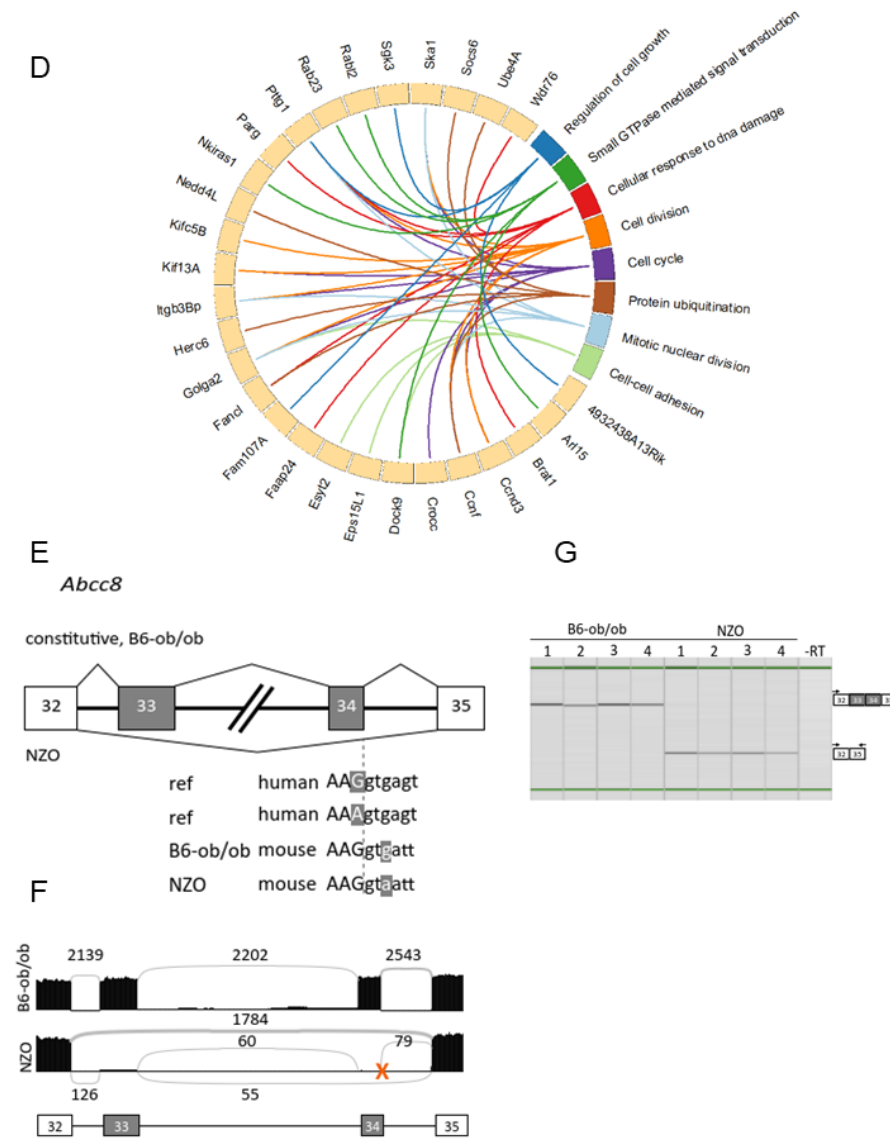
Figure 5. Impact of SNPs on alternative splicing. ( A ) Enrichment of RBP motifs in or close to differentially spliced exons and the predicted consequence for exon inclusion. ( B ) Enrichment of SNPs affecting cassette exon (CE) splicing. Bar graph summarizing the global SNPs frequency vs. SNPs located in close proximity to CE *** p ≤ 0.001, chi 2 test. ( C ) Schematic illustration of a SNP in a SRSF1 binding site downstream of an alternative exon in Akr1c12 . This polymorphism leads to enhanced skipping in islets from NZO mice. Sashimi plot and quantification are shown below. The numbers above the lines indicate the raw sequencing reads. Orange “X” marks the approximate position of RBP motif-changing SNPs. A simplified exon-intron structure is shown below the Sashimi plot. ( D ) Circos plot summarizing results of the gene ontology analysis of genes carrying SNPs in or in proximity to splice sites. Each line relates a gene to the indicated pathway, with each color representing one biological process. For example, green lines depict the connection to small GTPase mediated signal transduction pathway. ( E ) Schematic presentation of the Abcc8 exons 33 and 34 of splicing in B6-ob/ob (top) and NZO islets (bottom). Illustration of SNPs (highlighted in grey) in proximity of the splice site in the human or mouse B6-ob/ob and NZO sequence. Capital letters indicate exonic bases, small letters indicate intronic bases. Dashed grey line represents exon/intron boundary. ( F ) Sashimi plot of Abcc8 from B6-ob/ob and NZO islets showing raw sequencing reads above a simplified exon-intron structure. Orange “X” marks the approximate position of SNPs in the NZO sequence. ( G ) Results of splice sensitive RT-PCR with RNA from islets of 4 B6-ob/ob and NZO mice separated on a QIAxcel machine. Green lines indicate the alignment marker. Arrows above simplified exon structure indicate primer